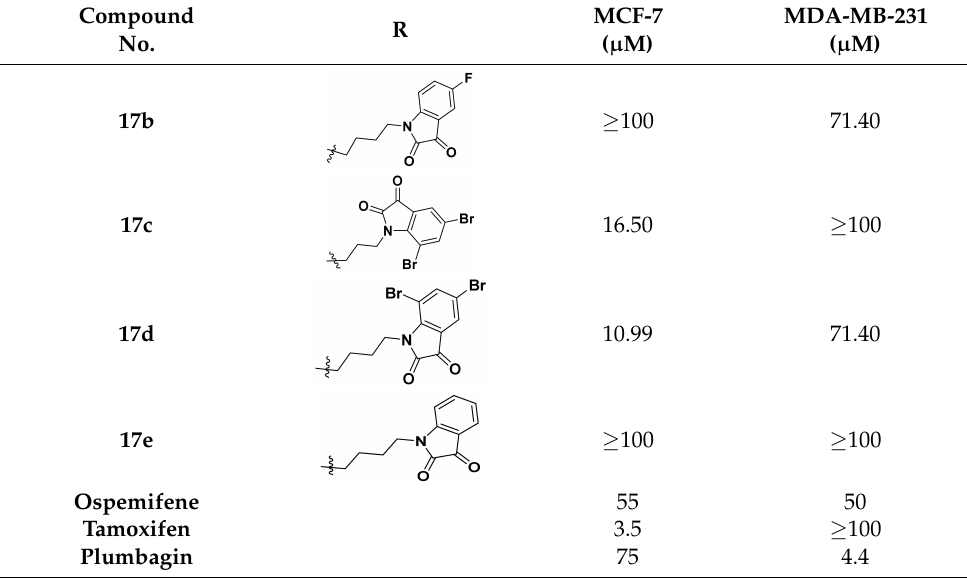
Table 17. In vitro cytotoxic activities of indole-ospemifene-triazole based hybrid compounds 17 ( b – e ).